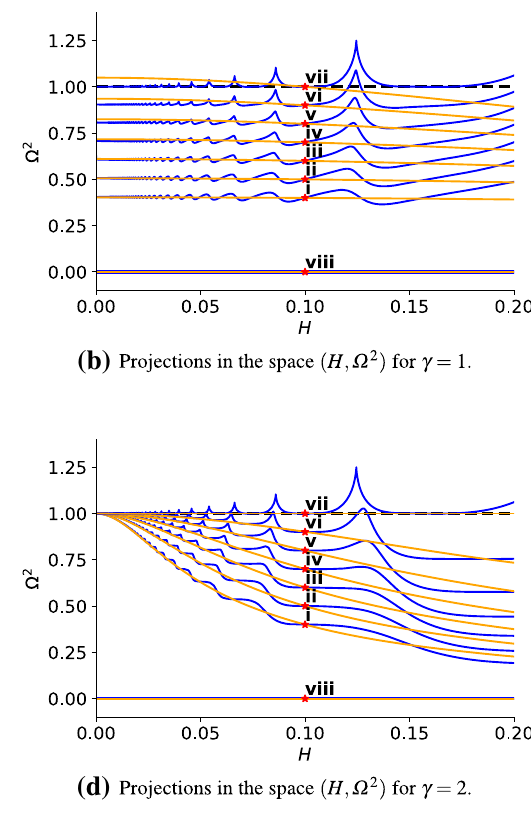
Fig. 7 Some solutions of full system (44) with Σ = 0 (blue) and time- averaged system (98) or (103) if γ = 1 (orange) for flat FLRW metric ( k = 0) when the matter fluid correspond to: a cosmological constant, b dust, c radiation and d stiff fluid. The black line represents the con-